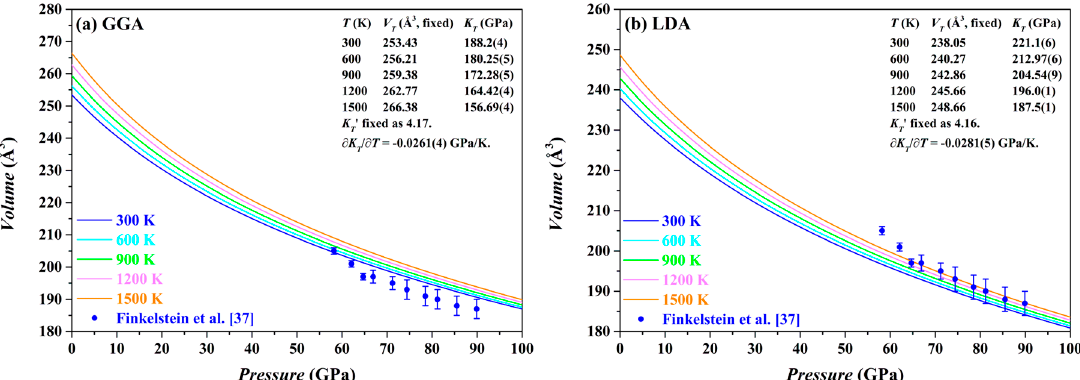
Figure 12. Calculated P-V curve for Fo-III at 300, 600, 900, 1200 and 1500 K from 0 to 100 GPa: ( a ) the GGA method ( b ) the LDA method. For comparison, the experimental results obtained by Finkelstein et al. [37] at 300 K are also shown.